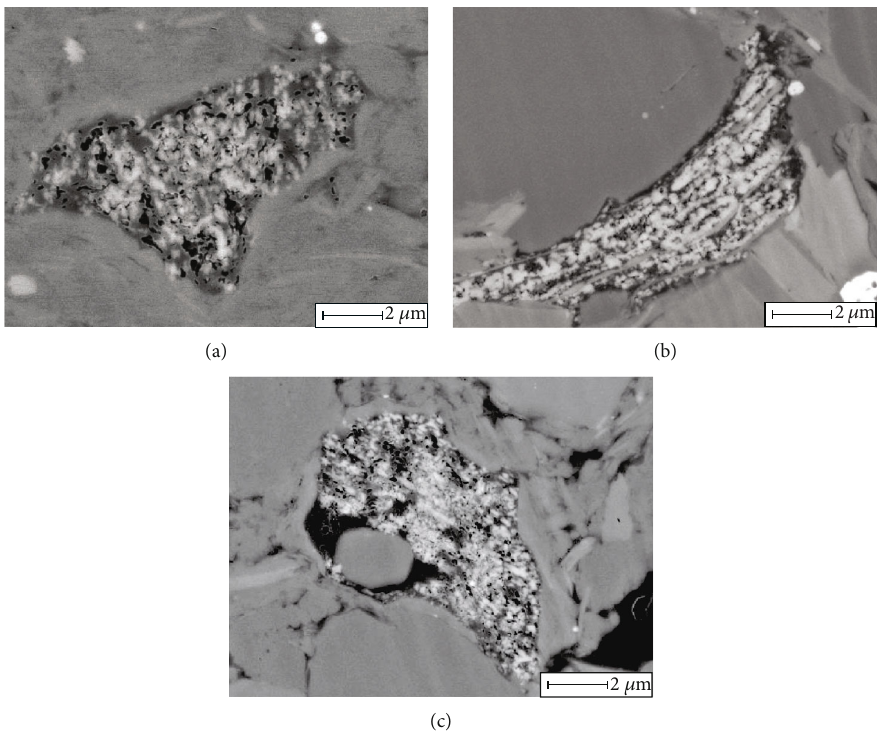
Figure 9: Pore characteristics of the algae in the Wufeng-Longmaxi Formation shale at the southeast Sichuan Basin.